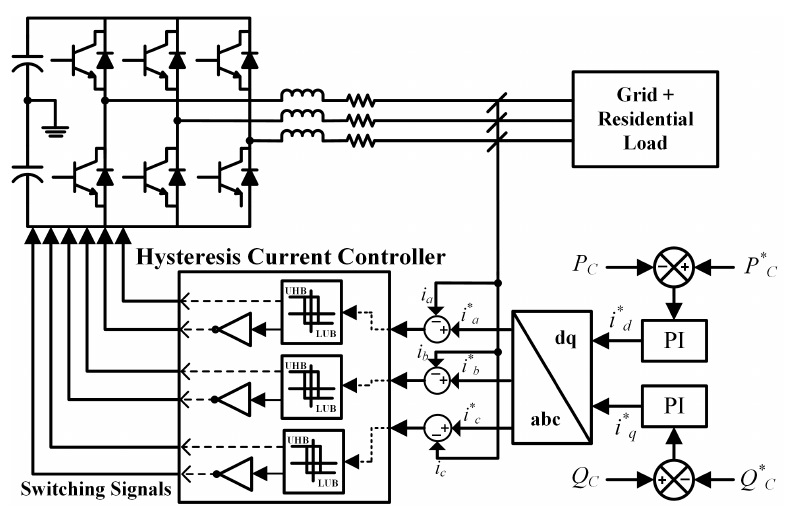
Figure 3. Control system of grid connected inverter